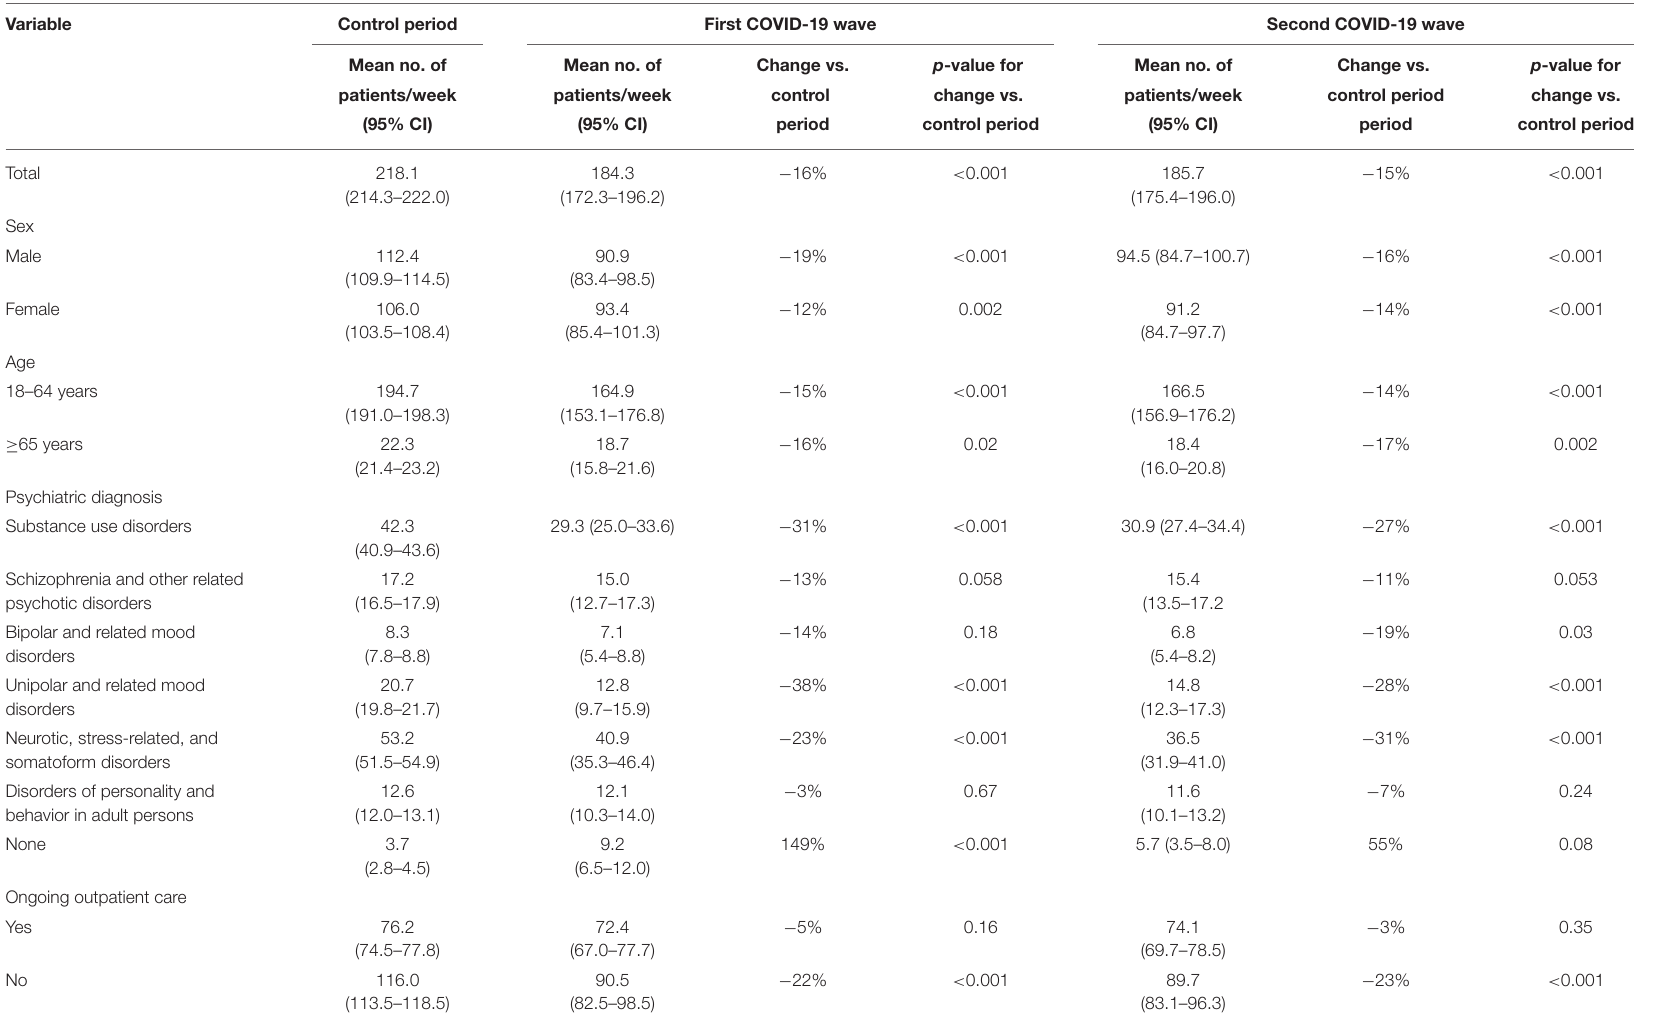
TABLE 1 | Change in number of weekly patient visits to the Sahlgrenska University Hospital Psychiatric Emergency Department during the first and second COVID-19 waves compared to pre-COVID 19 control period: overall, by patient demographic characteristics and psychiatric diagnosis, and ongoing outpatient care.